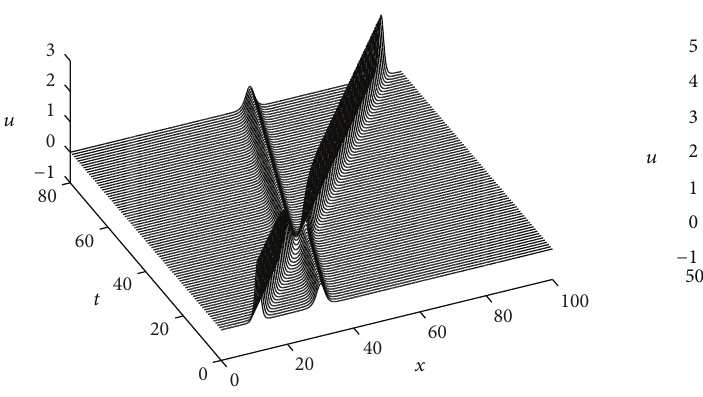
Figure 6: Inelastic interaction: numerical solution 𝑈 𝑛 with 𝑎 = 0.495 .